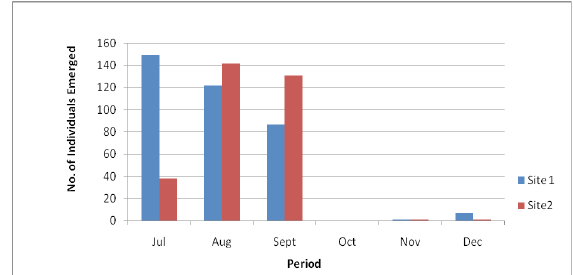
Fig. 1. Monthly seedlings emergence densities in the rainy season in Sites I and Sites